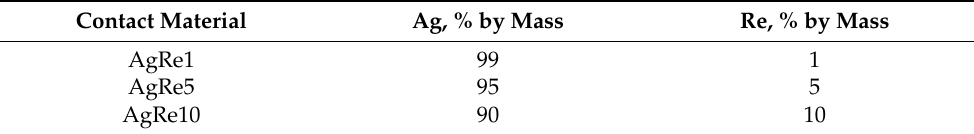
Table 2. Chemical composition of the mixtures.